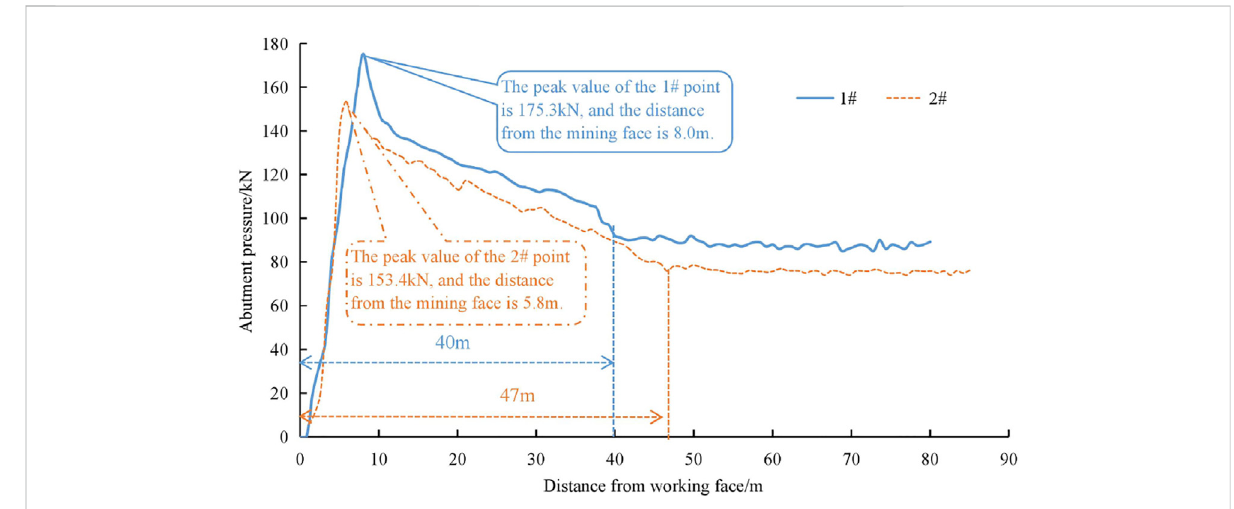
FIGURE 7 Variation curve of the advanced abutment